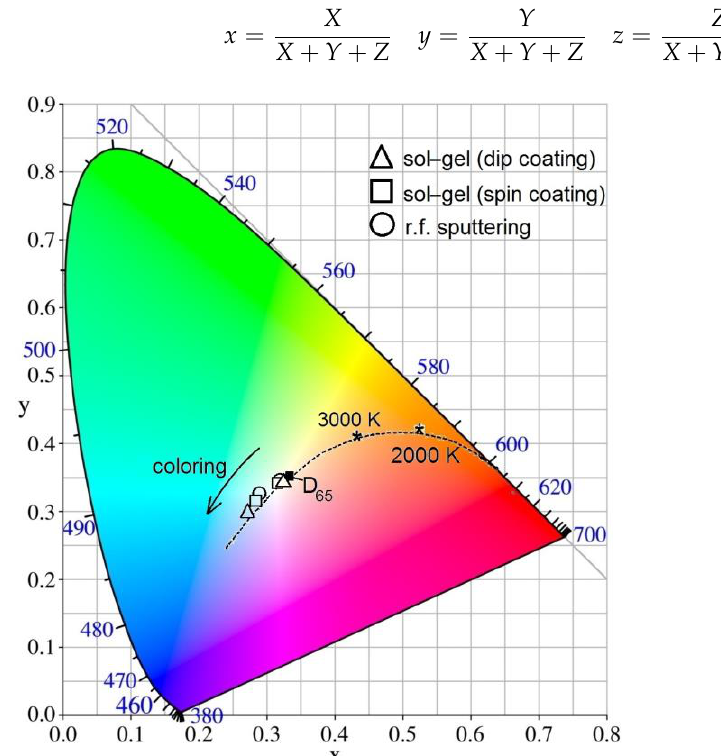
Figure 3. CIE-xy 1931 chromaticity diagram reporting the chromaticity coordinates of the D 65 light when filtered through the investigated EC glazing switched in the fully bleached and fully colored states. The dashed line represents the blackbody locus with indicated color temperatures (stars). The chromaticity of illuminant D 65 is represented by the full block.